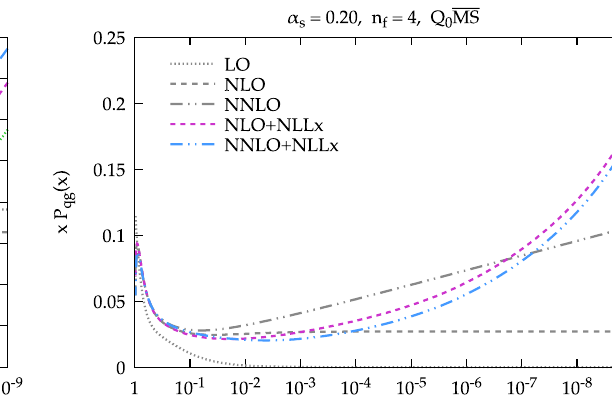
small- x resummation. The comparison is performed at a scale such that = 0 . 2 and in the Q = 4 active quark α s 0 MS scheme with n f